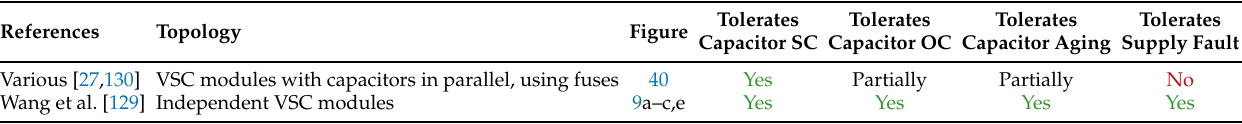
Table 25. Methods for tolerating dc-link capacitor faults (Section 12.1) in multiphase applications in the literature.